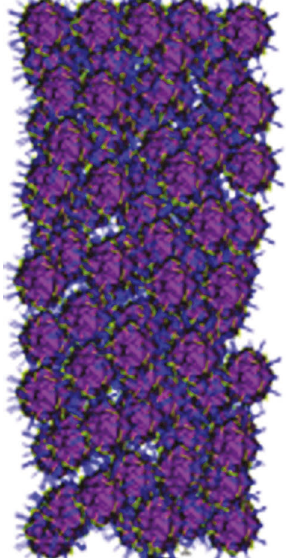
Figure 1: Model of random aggregate.